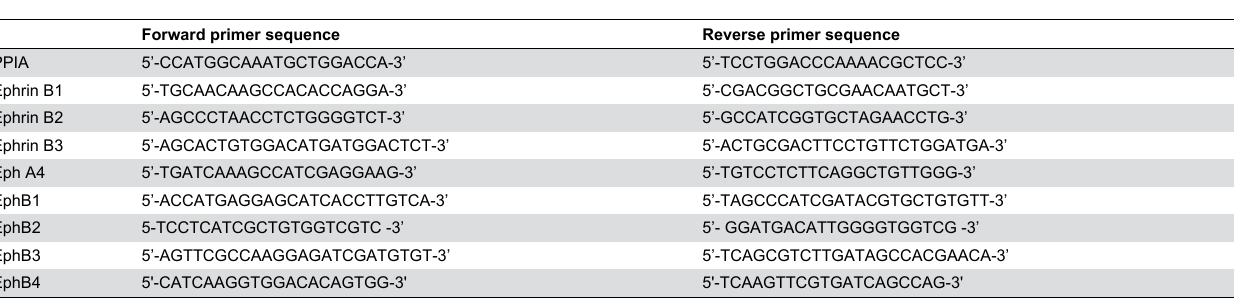
Table 1. Primer sequences used for real time